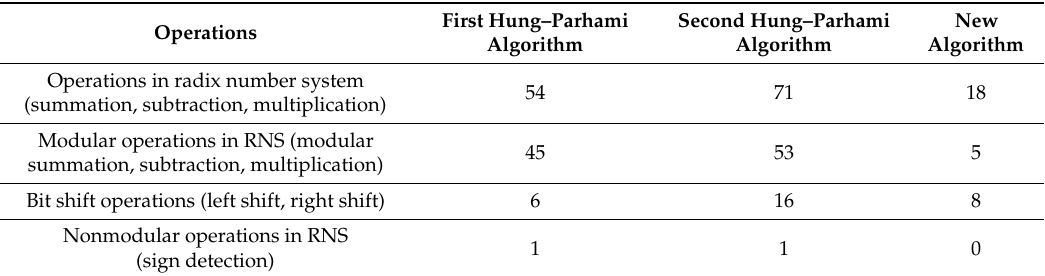
Table 3. Comparison of Hung-Parhami algorithms with new algorithm.